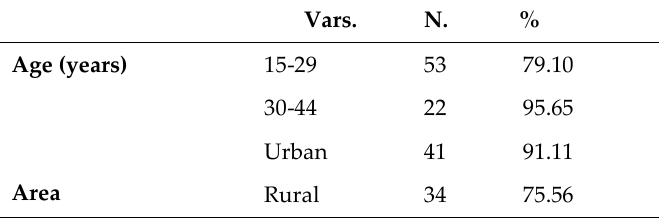
Table 3: Distribution of Caries status by age and area